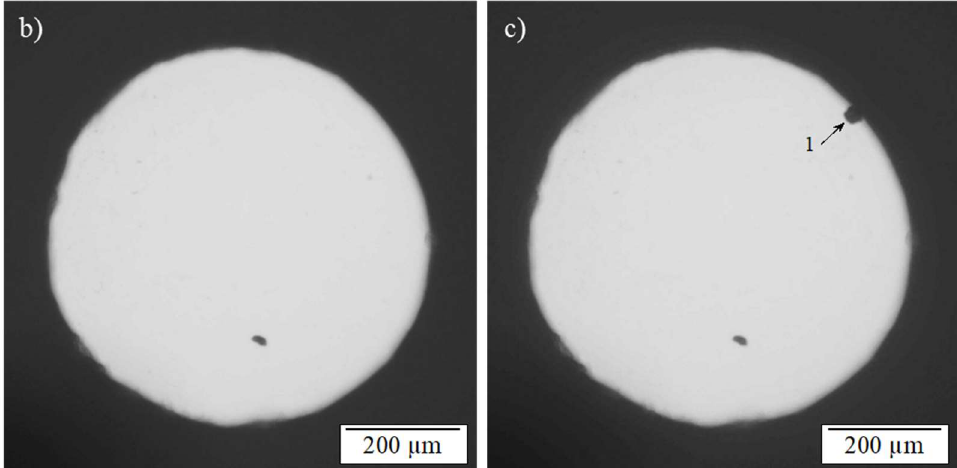
Figure 6. Electrochemical results and two frames out of a video of the in situ microscopic analysis of the 1.4016 at a chloride ion concentration of 500 mg/L and a test area diameter of 0.5 mm. ( a ) Current density-potential curve, ( b ) start of the video 0 s (225 mV); ( c ) after 360 s at the end of the video (585 mV).